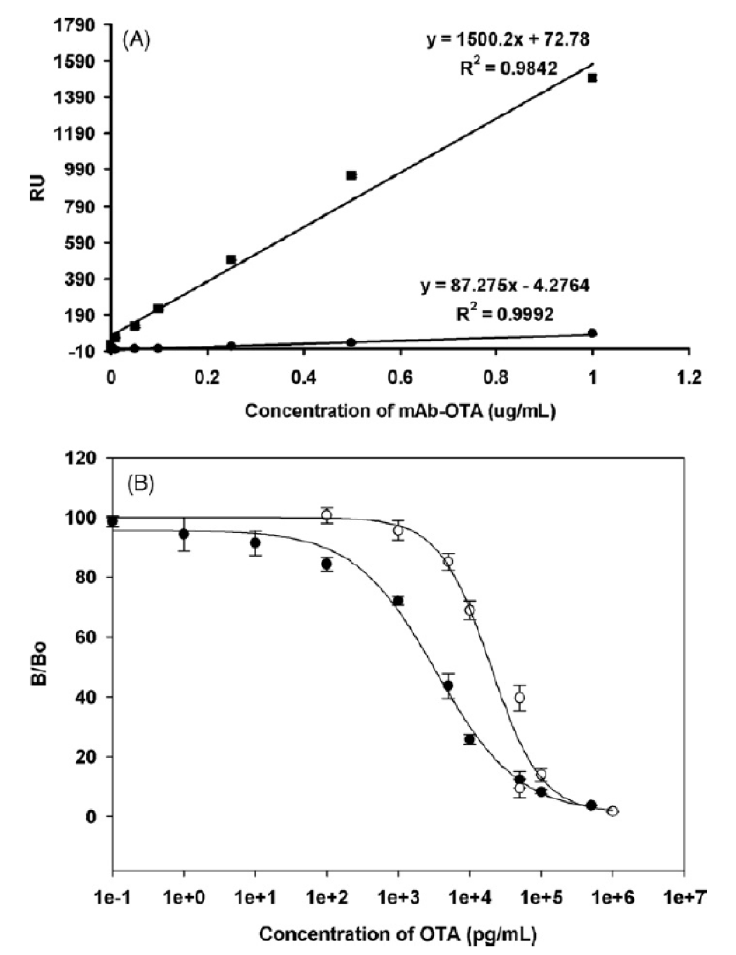
Figure 6. A: Plot of response (RU) v. primary antibody concentration for mAb only ( ● ) and 40 nm immunogold enhancement ( ■ ). B: Assay standard curves for mAb only format ( ○ ) and 40 nm immunogold enhanced format ( ● ). Reprinted from reference [12], with permission from Elsevier. Copyright